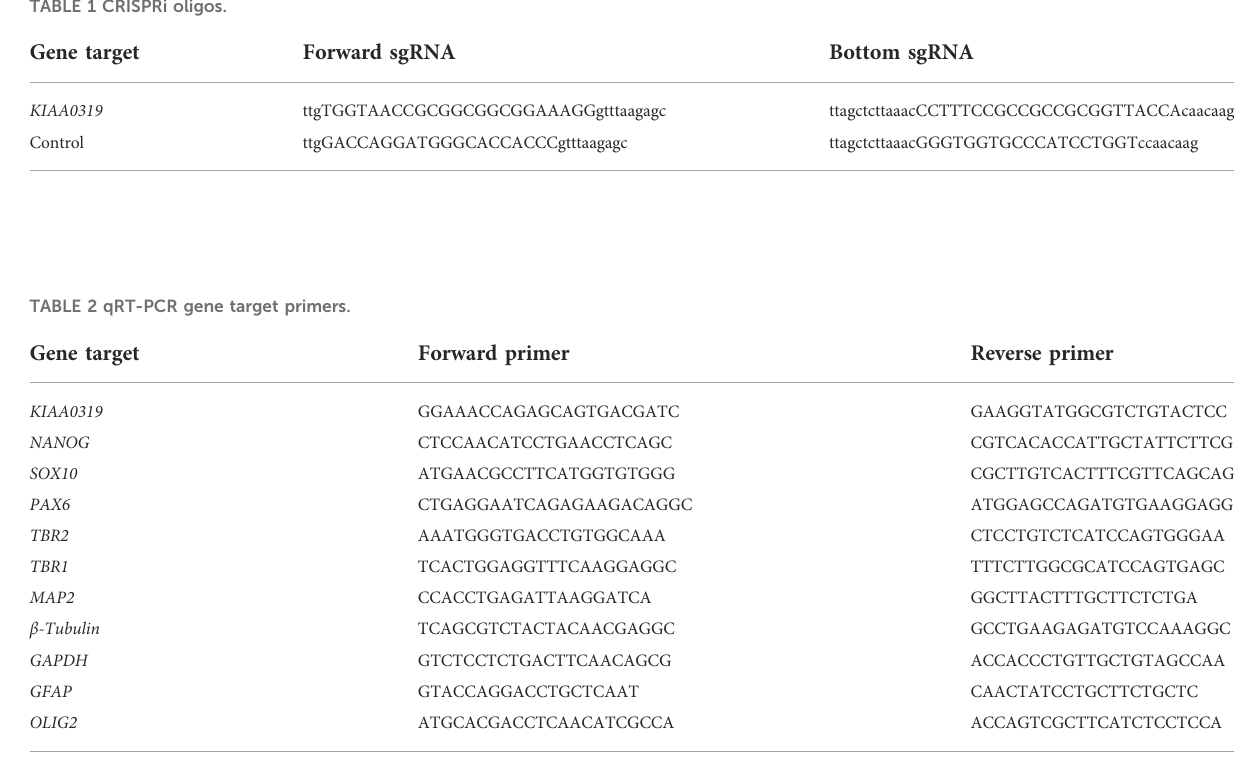
TABLE 1 CRISPRi oligos.